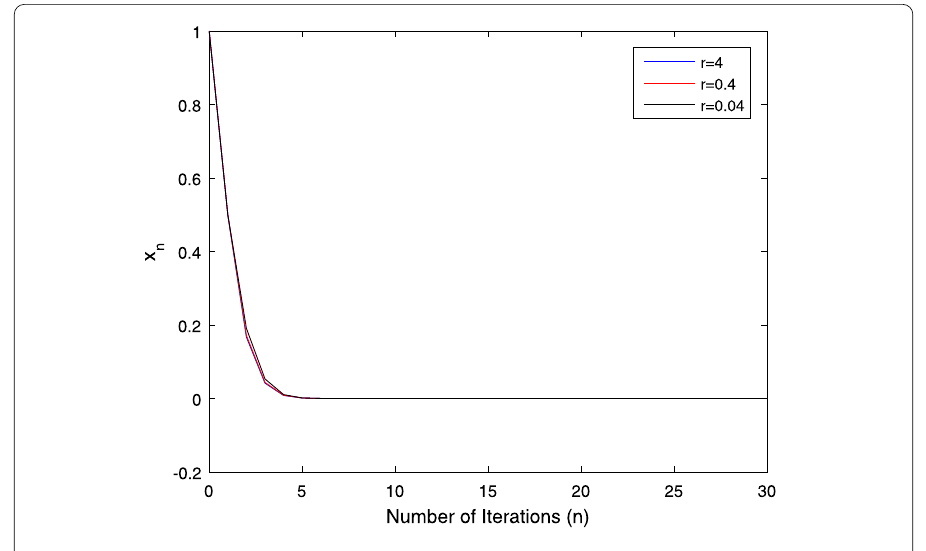
Figure 2 Behaviors of { x n } with different r = 4,0.4,0.04, x 1 = 1 and η = 1